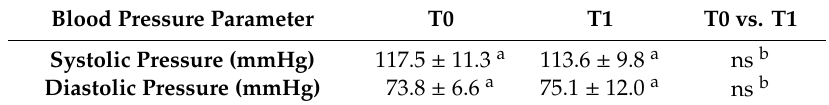
Table 6. Blood pressure parameters of healthy subjects.